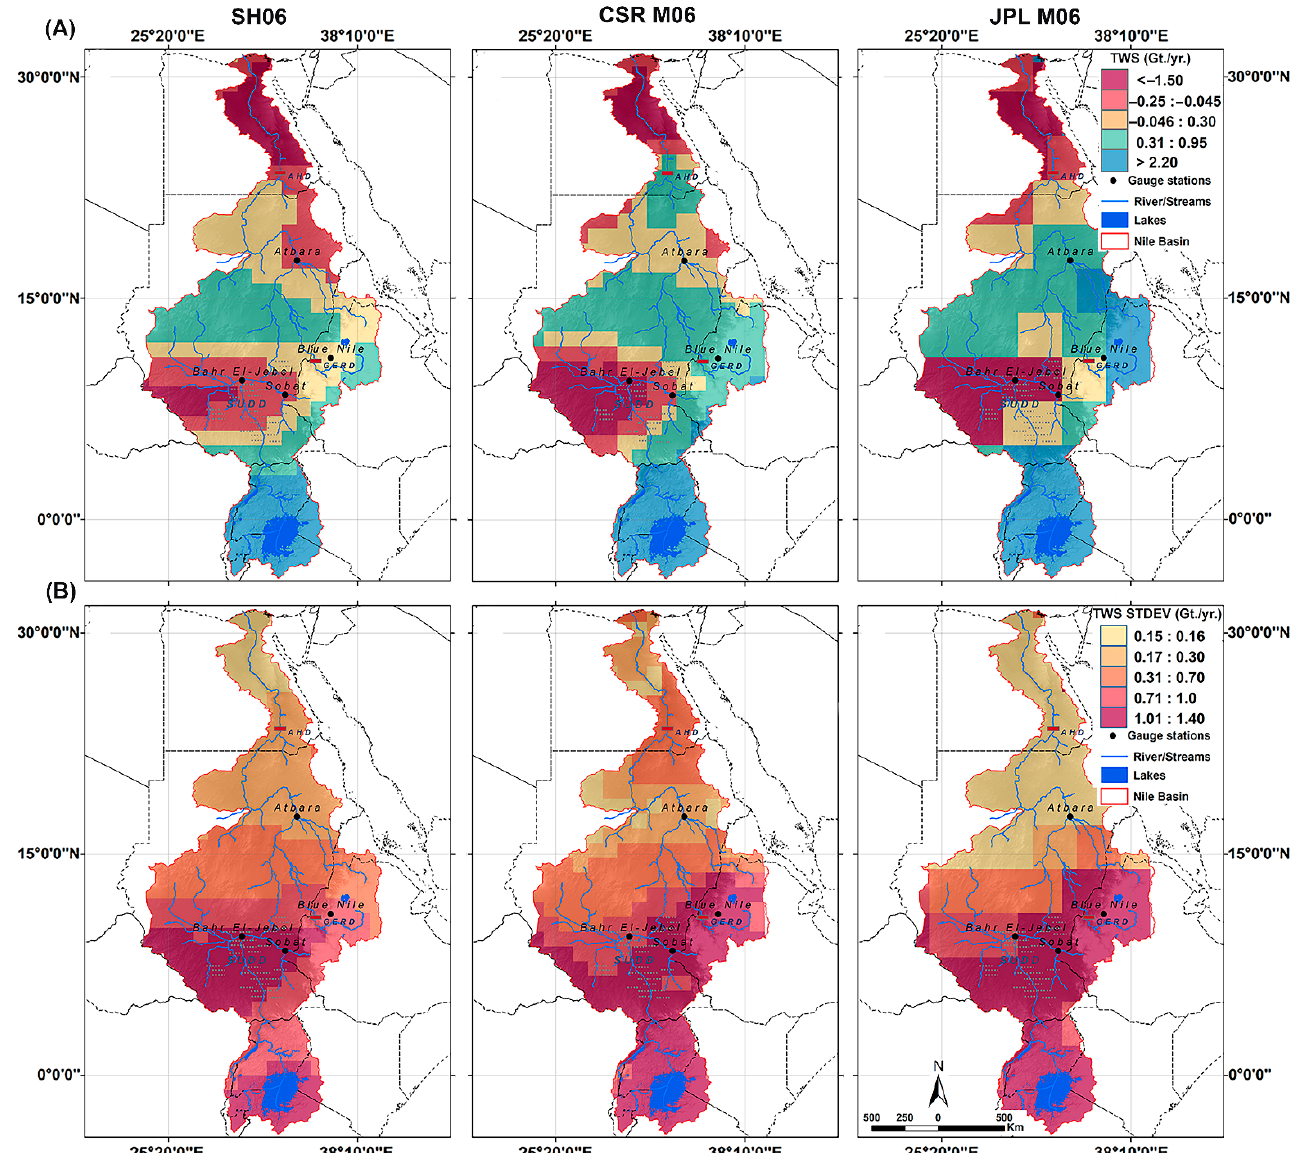
Figure 8. Mean annual average GRACE-FO TWS ( A ) between 2018–2020 using ensembled SH06, CSR-M06, and JPL-M06 mascon solutions, plot ( B ) shows the standard deviation of each solution during the studied period.